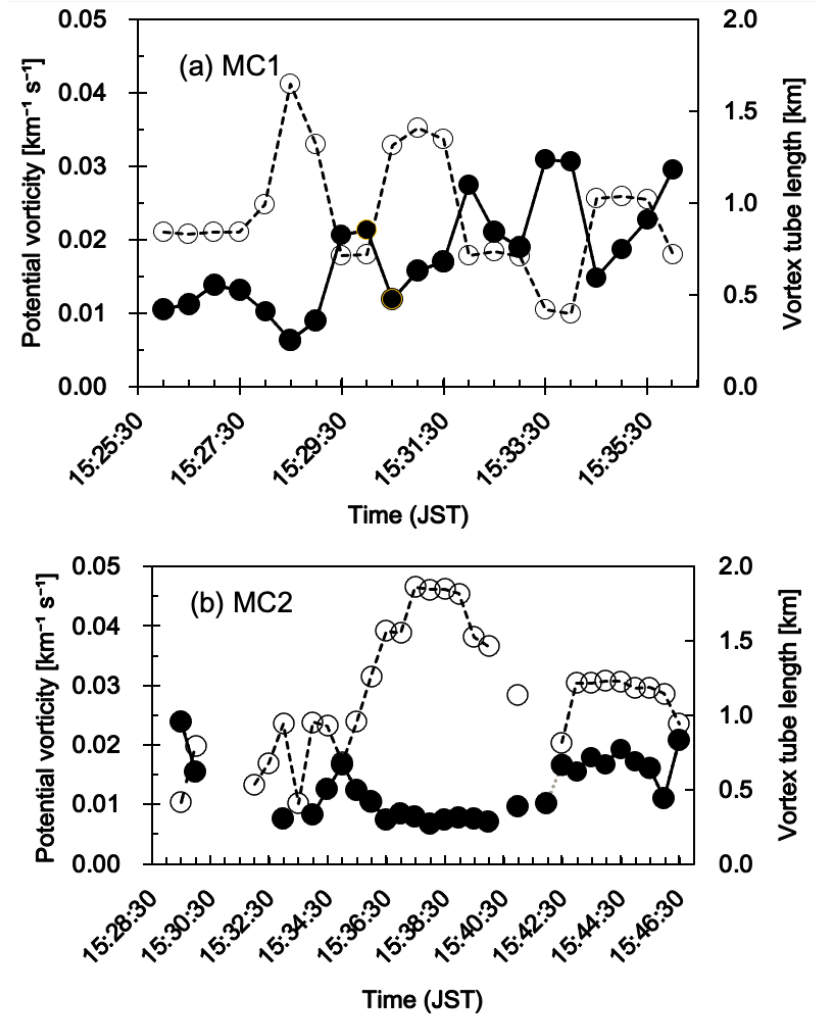
Figure 9. Time series of potential vorticity (solid circles) and length of the vortex tube (open circles) of ( a ) MC1 and ( b ) MC2.